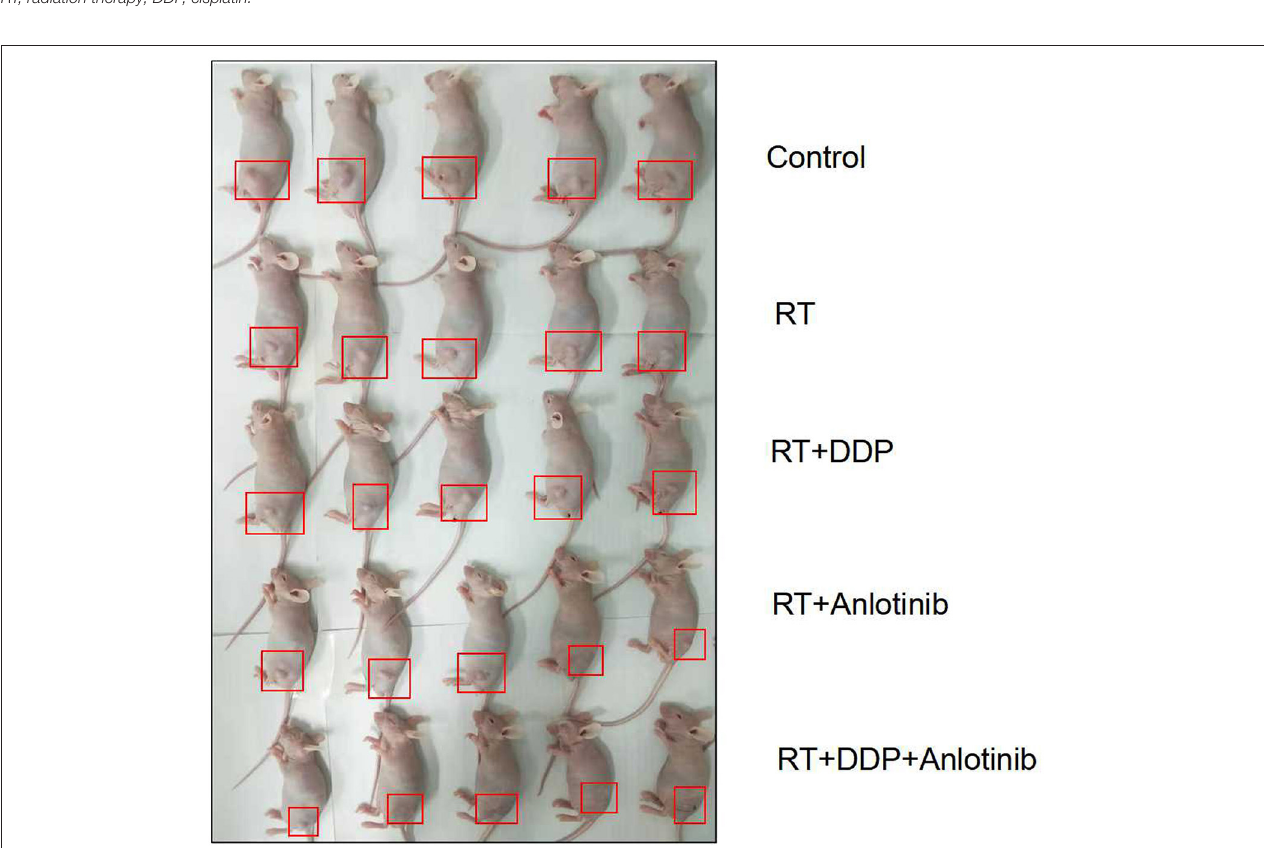
FIGURE 3 | Intuitive antitumor efficacy in patient-derived xenograft (PDX) models showed that the tumor in the anlotinib combined with chemoradiation-treated group shrank the most.